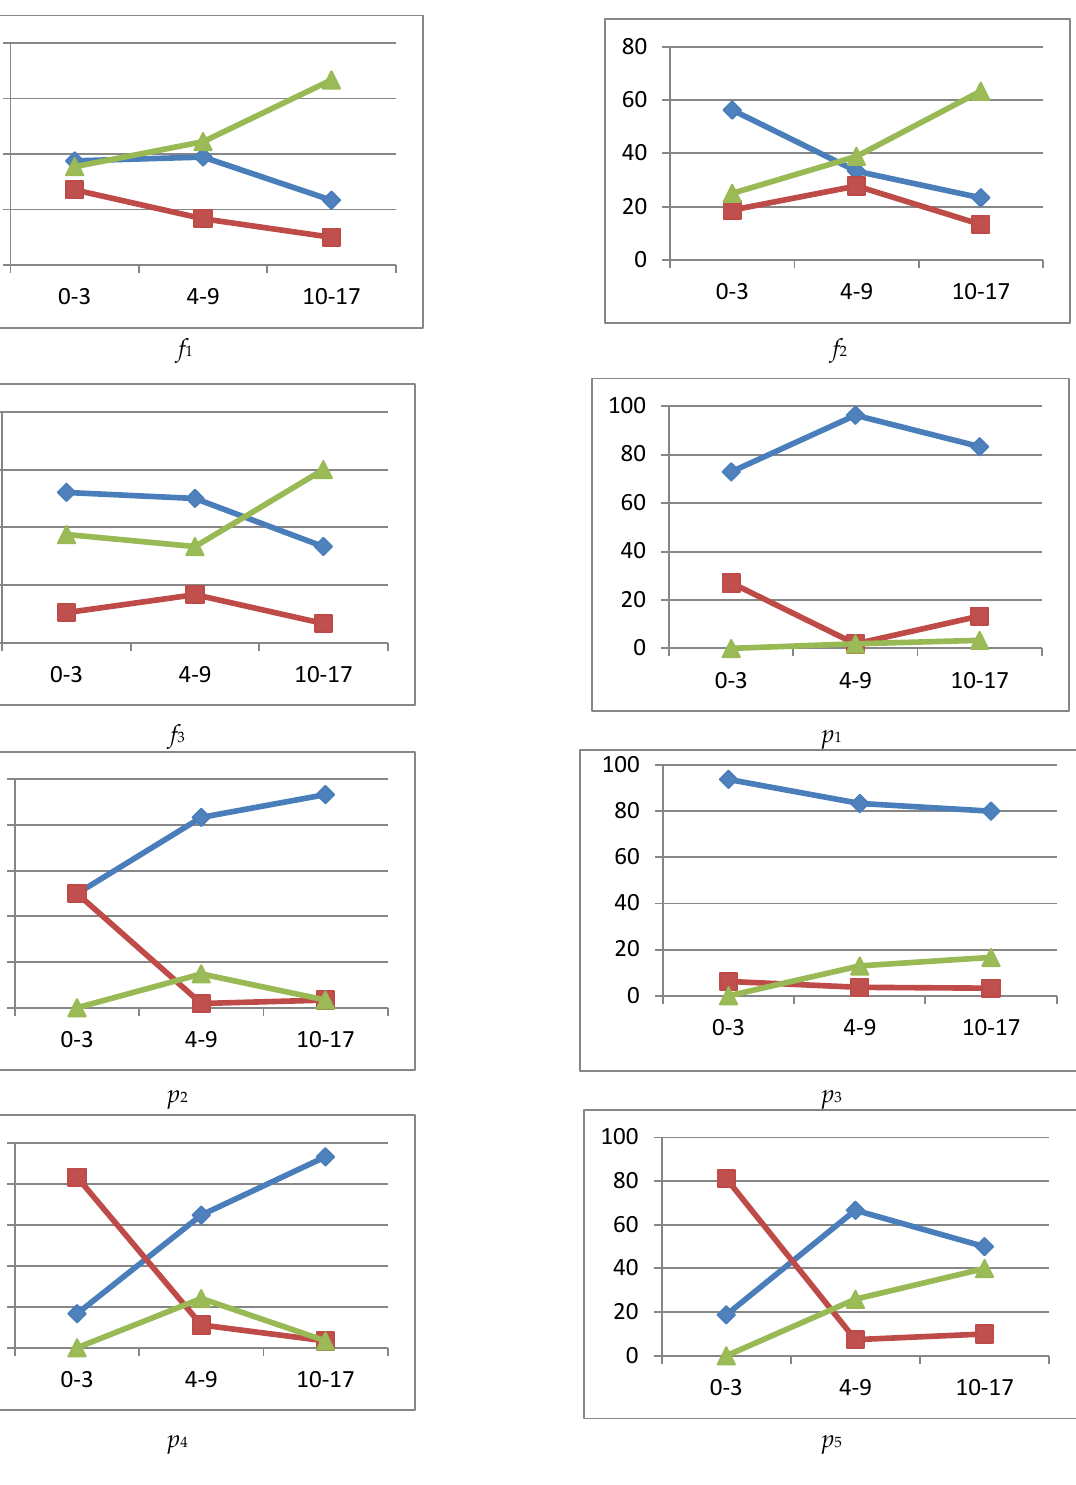
Figure 2. Graphs of deviations in immunogram indicators for the state of the immune system k 1 , reference interval, exceeding the reference interval, subceeding the reference in- terval. Table 4. Immunogram analysis for the state of the immune system k 2 .